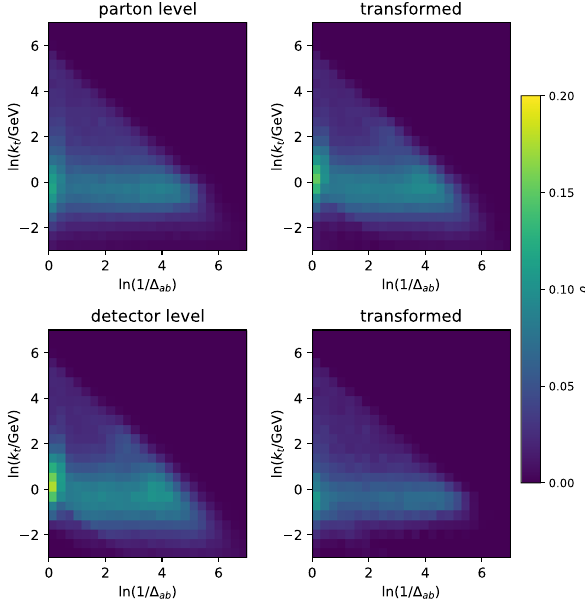
Fig. 12 Top: average of the parton-level sample before (left) and after (right) applying the parton-to-detector mapping. Bottom: average of the delphes-level sample before (left) and after (right) applying the detector-to-parton mapping